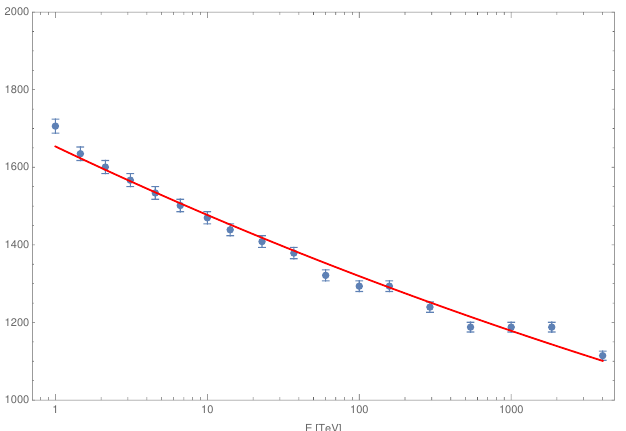
Figure A1. Average distance from the centre of cascade R prc within which 95% of particles produced in the shower initiated by protons are contained.